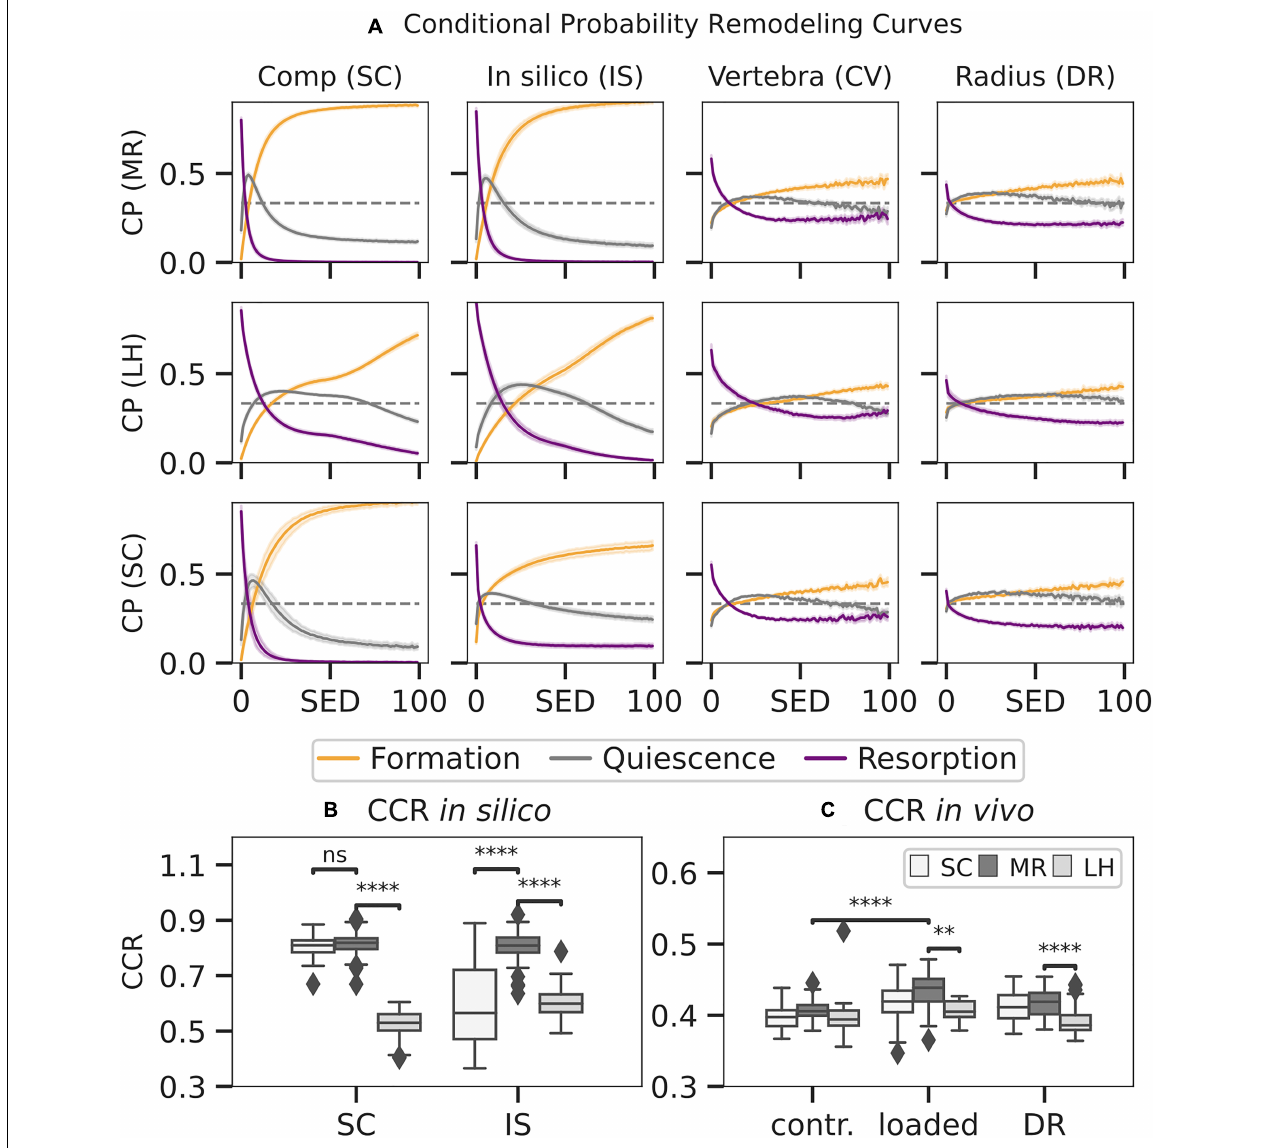
FIGURE 7 | Conditional remodelling probabilities (CPs) connecting the mechanical environment [strain energy density (SED)] as estimated by mechanoregulation-based load estimation (MR), load history (LH), and simple compression (SC) with remodelling sites for SC, in silico loading (IS), in vivo vertebra (CV), and distal radius (DR) datasets. Normalised SED distributions were used to calculate the CP (A) for events of formation, quiescence, and resorption to occur at distinct strain levels. Remodelling sites as predicted by the estimated SED were compared to the ground truth, and a correct classification rate (CCR) for in silico data (B) and in vivo data (C) was calculated. Boxplots indicate the median and interquartile range. Observations outside the 9–91 scope plotted as outliers. Differences in prediction within and between groups with p < 0.05 are indicated ( ∗∗ p < 0.001; ∗∗∗∗ p < 0.0001; ns p > 0 . 05, two-tailed paired t -test within groups, two-tailed individual t -test between